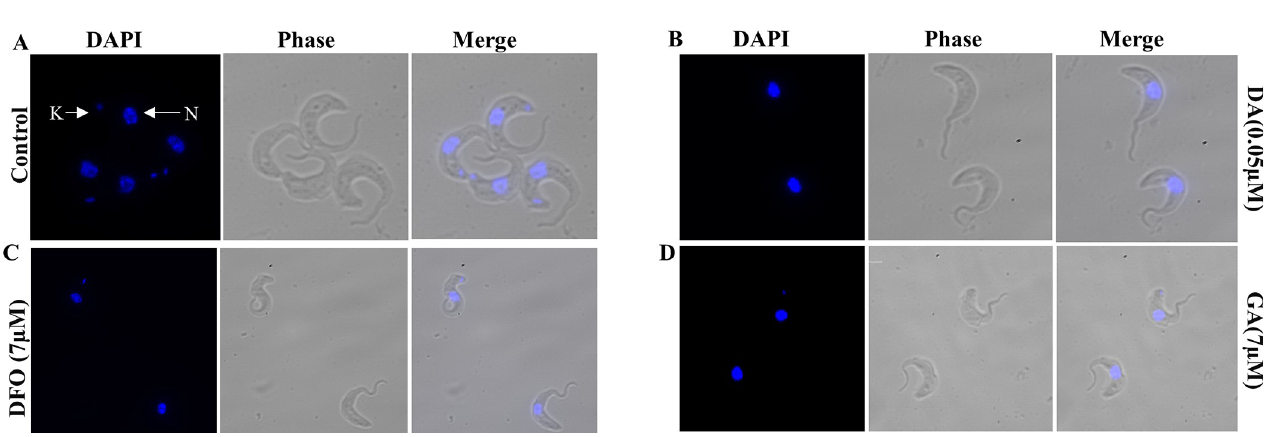
Fig 3. Effects of compounds on trypanosome morphology and DNA synthesis. T . b . brucei cells were treated with ½ IC 50 diminazene aceturate (DA); 2X IC 50 deferoxamine (DFO) and ½ IC 50 gallic acid (GA) for 24 hours, stained with DAPI for DNA (blue) and cell morphology visualized using the fluorescent microscope (100x). The nucleus is indicated as N and the kinetoplast as K.